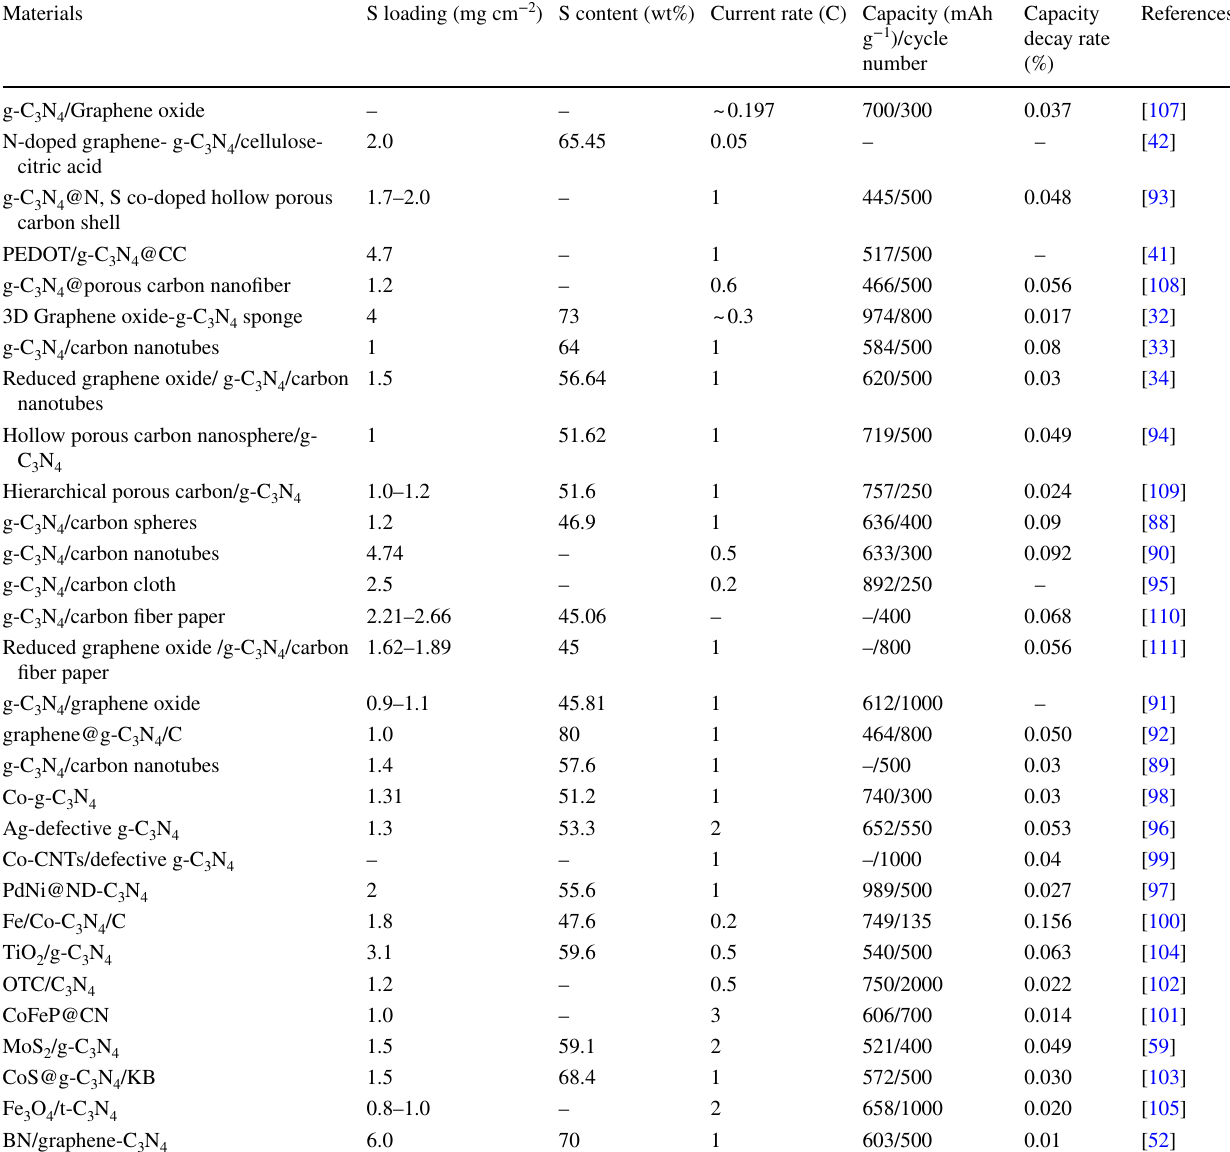
Table 2 Comparison of performances of Li–S cells with g‑C 3 N 4 ‑based composites